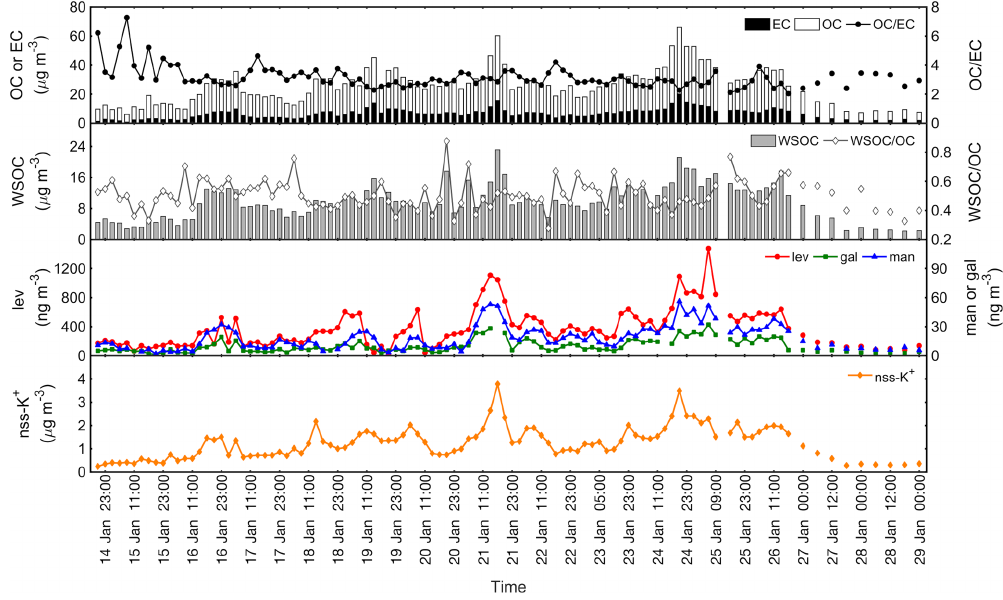
Figure 1. Time series of OC, EC, WSOC, levoglucosan (lev), mannosan (man), galactosan (gal) and non-sea-salt potassium (nss-K + ) concentrations as well as OC / EC and WSOC / OC ratios for PM 2 . 5 samples. The horizontal ordinate indicates the ending time for each